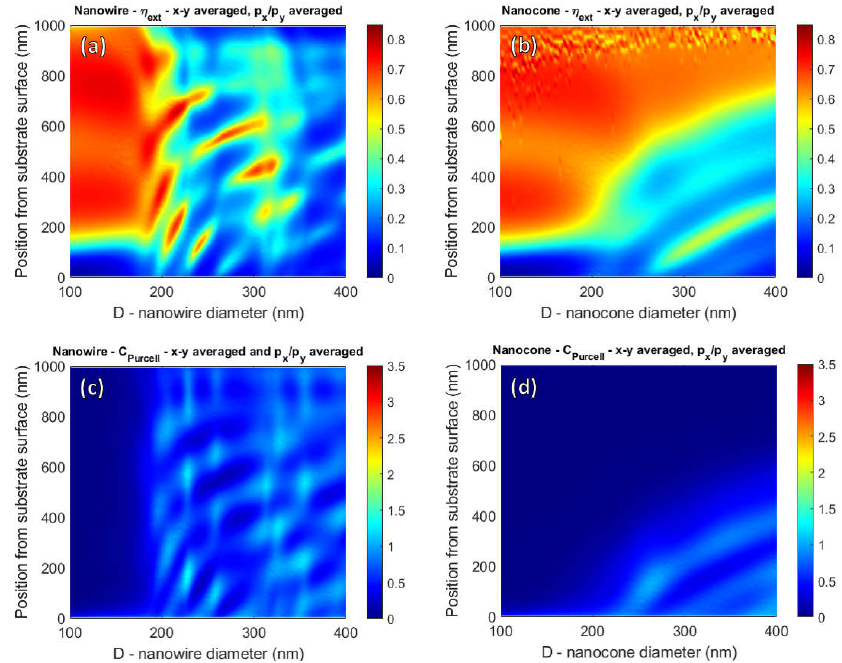
Figure 5. ( a , b ) Extraction efficiency, η ext , and ( c , d ) Purcell factor, C Purcell , for ( a,c ) a nanowire and ( b,d ) a nanocone. Here, we consider an emitter region that is 10 nm thick in the axial z direction, and we average for dipoles distributed in that x - y cross-section (as indicated in the figure titles by x-y averaged ). Furthermore, we consider an in-plane oriented dipole. That is, we average the results from x- and y- oriented dipoles for each position (as indicated in the figure titles by p x /p y averaged ). For the x - y- oriented dipole, we find for D < 200 nm in both nanowires and nanocones an extraction efficiency above 70% (Figure 5a,b: Note that for z emitter > 800 nm in the nanocones, η ext varies rapidly in the range from 0.55 to 0.8, and the origin of this intriguing behavior is left for future